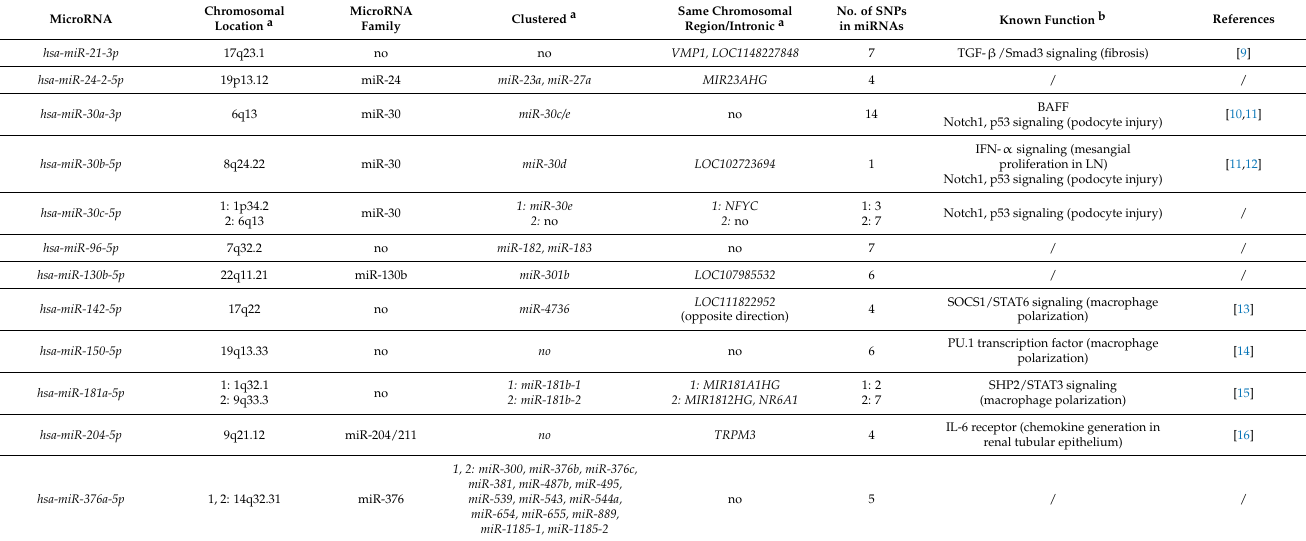
Table 3. Characterization of AAV-specific miRNAs.